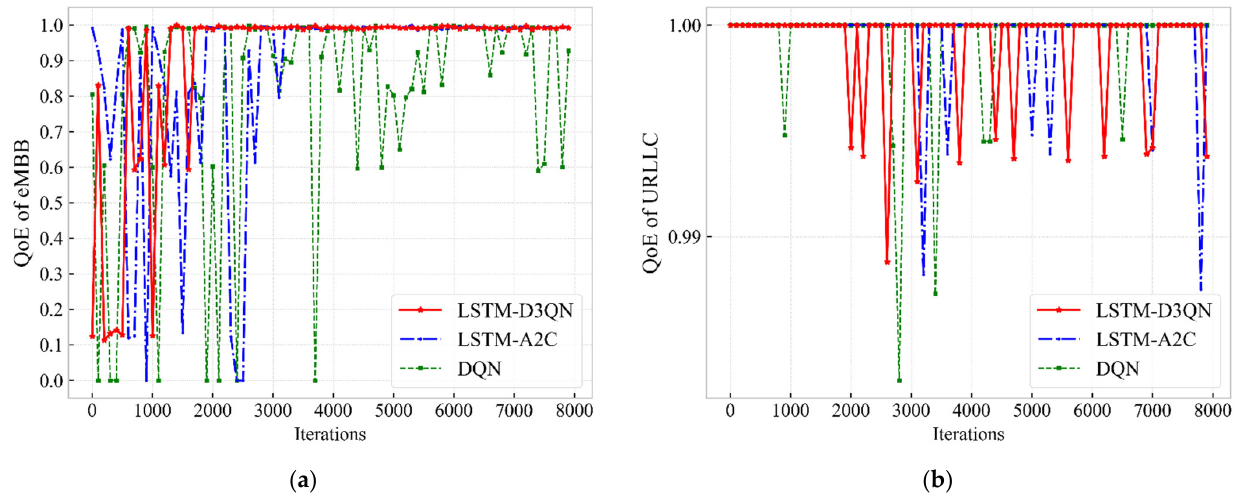
Figure 6. The comparison of QoEs for different methods. ( a ) The comparison of QoE of eMBB; ( b ) the comparison of QoE of URLLC.